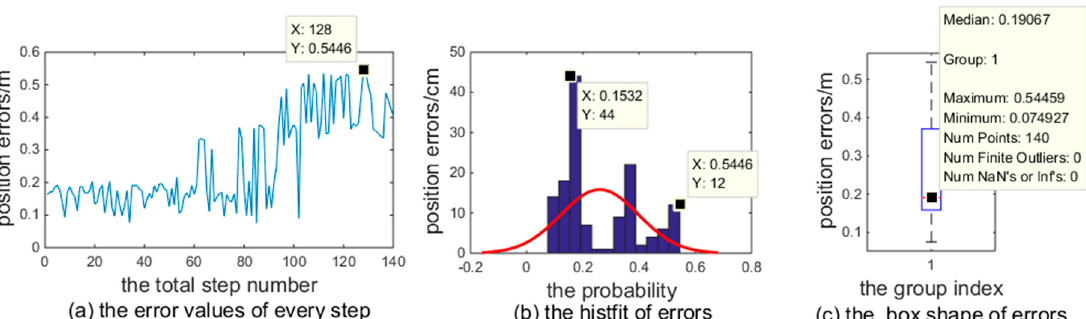
Figure 10. Analysis of the proposed system errors. ( a ) Error values of every step. Here, the step number 𝒦 = 140 ; ( b ) error probability distribution histogram produced by the MATLAB histfit function based on the data of ( a ); and ( c ) result of the MATLAB box function based on the data of ( a ), describing the distribution of the collected data and visualizing the normalities and abnormalities of the data.